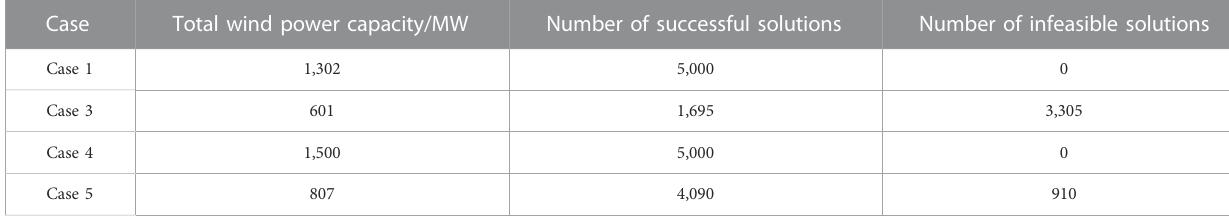
TABLE 10 Monte Carlo simulation